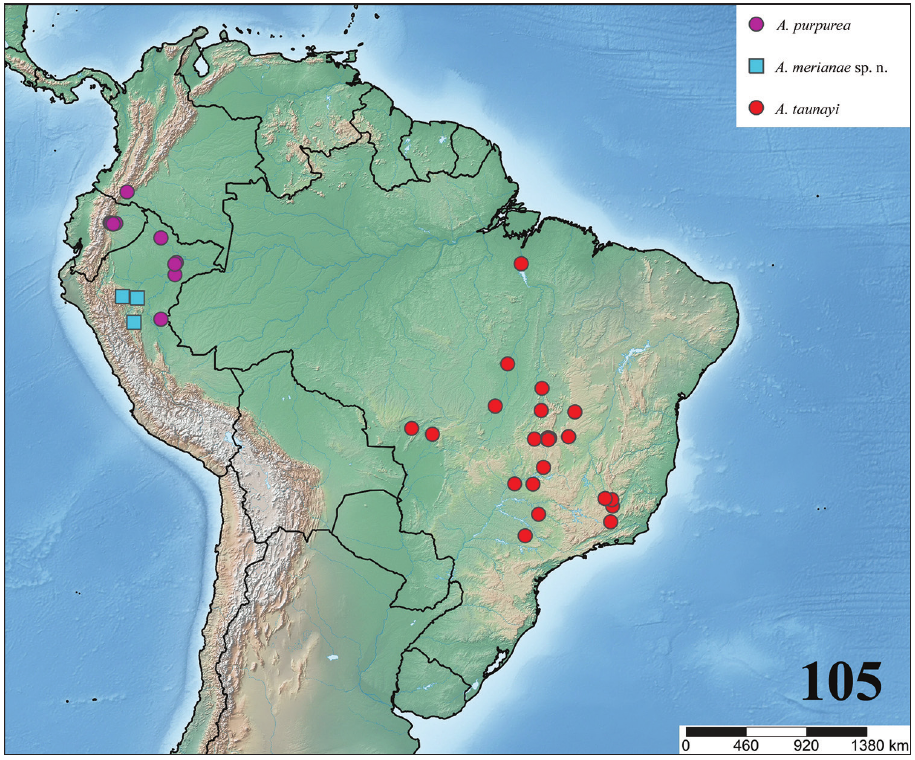
Figure 105. Map showing records of Avicularia taunayi (Melo-Leitão, 1920), Avicularia purpurea Kirk, 1990 and Avicularia merianae sp.